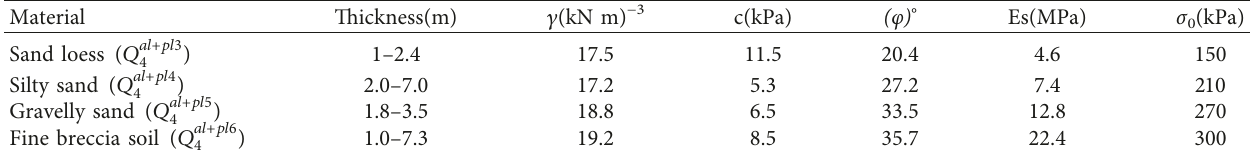
Table 2: Soil parameter of Pingchuan